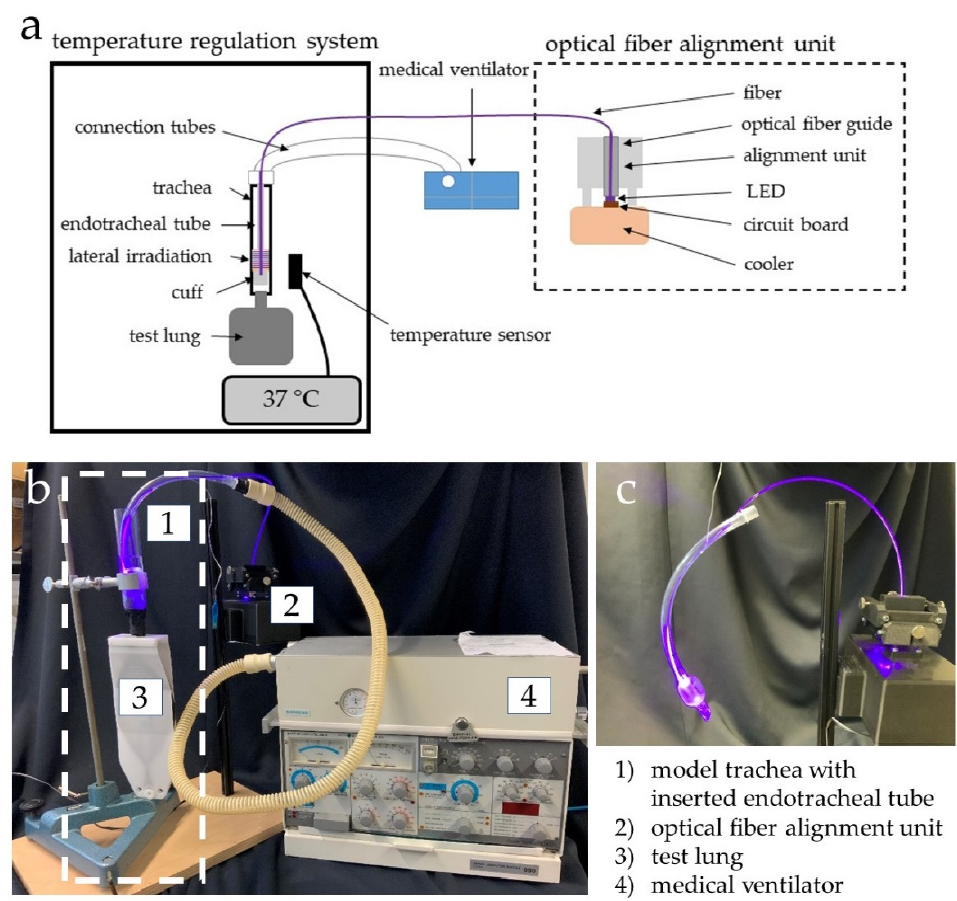
Figure 1. Schematic test setup of temperature regulated trachea model with LED based fiber optic integrated in an ETT and the lateral bacterial irradiation ( a ), photograph of the test setup with the dashed box indicating the 37 °C tempered part ( b ) and endotracheal tube with inserted optical fiber emitting 405 nm light in the area around and above the cuff ( c ).